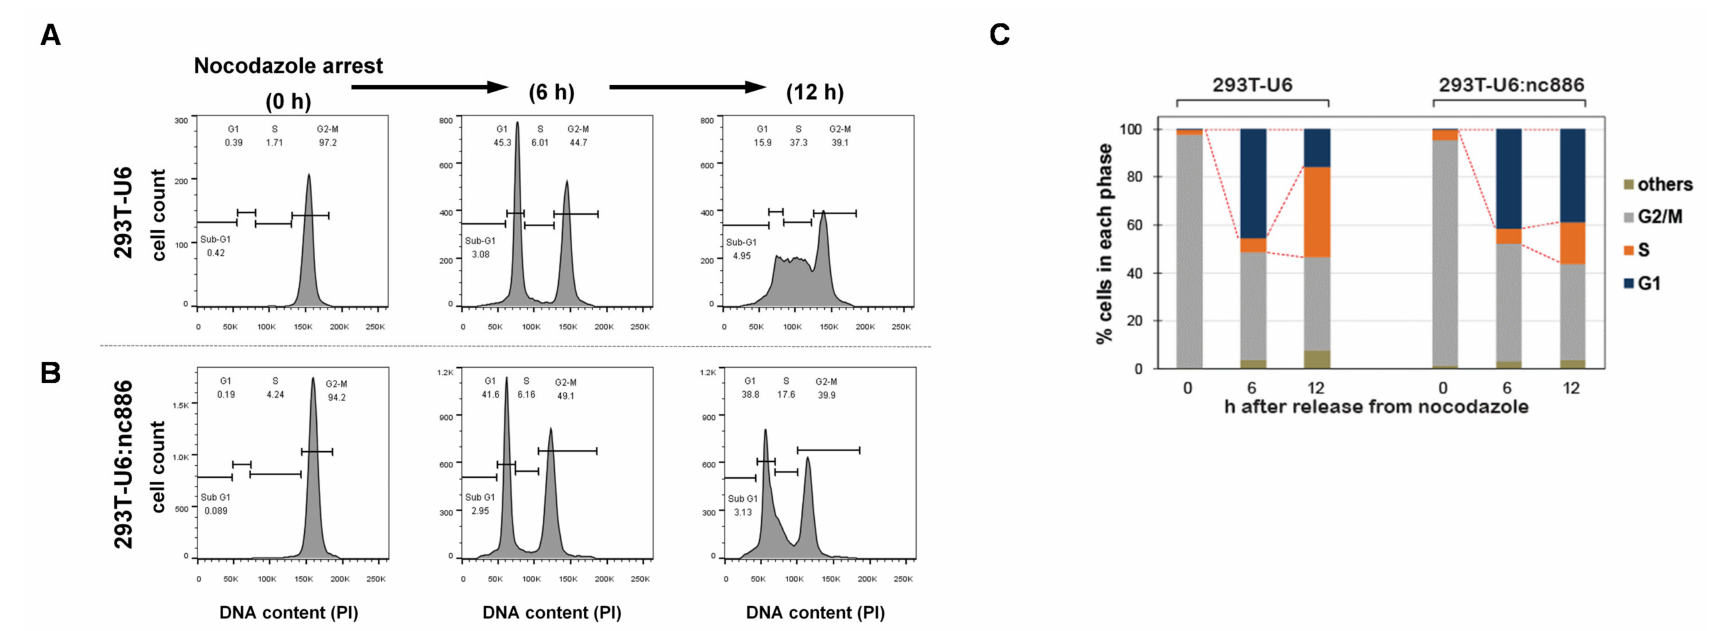
Figure 2. nc886 arrests cell cycle at the G1 phase. ( A , B ) FACS cell cycle profiles shown by propidium iodide (PI) staining of DNA contents. Cells were treated with nocodazole and were harvested just before release (0 h) and at indicated time points afterward. From the FACS data ( B ), cells at G1, S, G2, and other (mainly sub-G1) phases were counted and each fraction was calculated ( C , bar graph). A representative result from duplicate experiments is